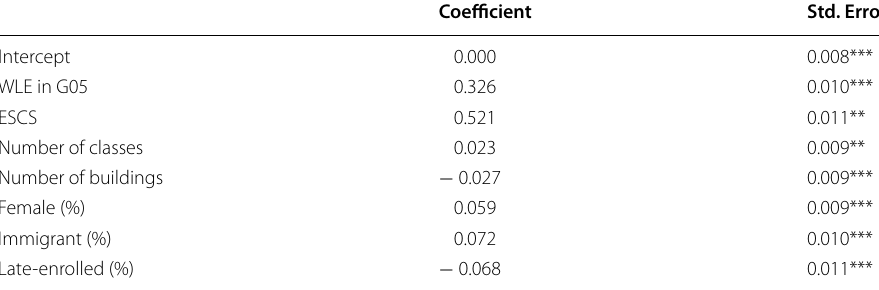
Table 2 Results of OLS regression model